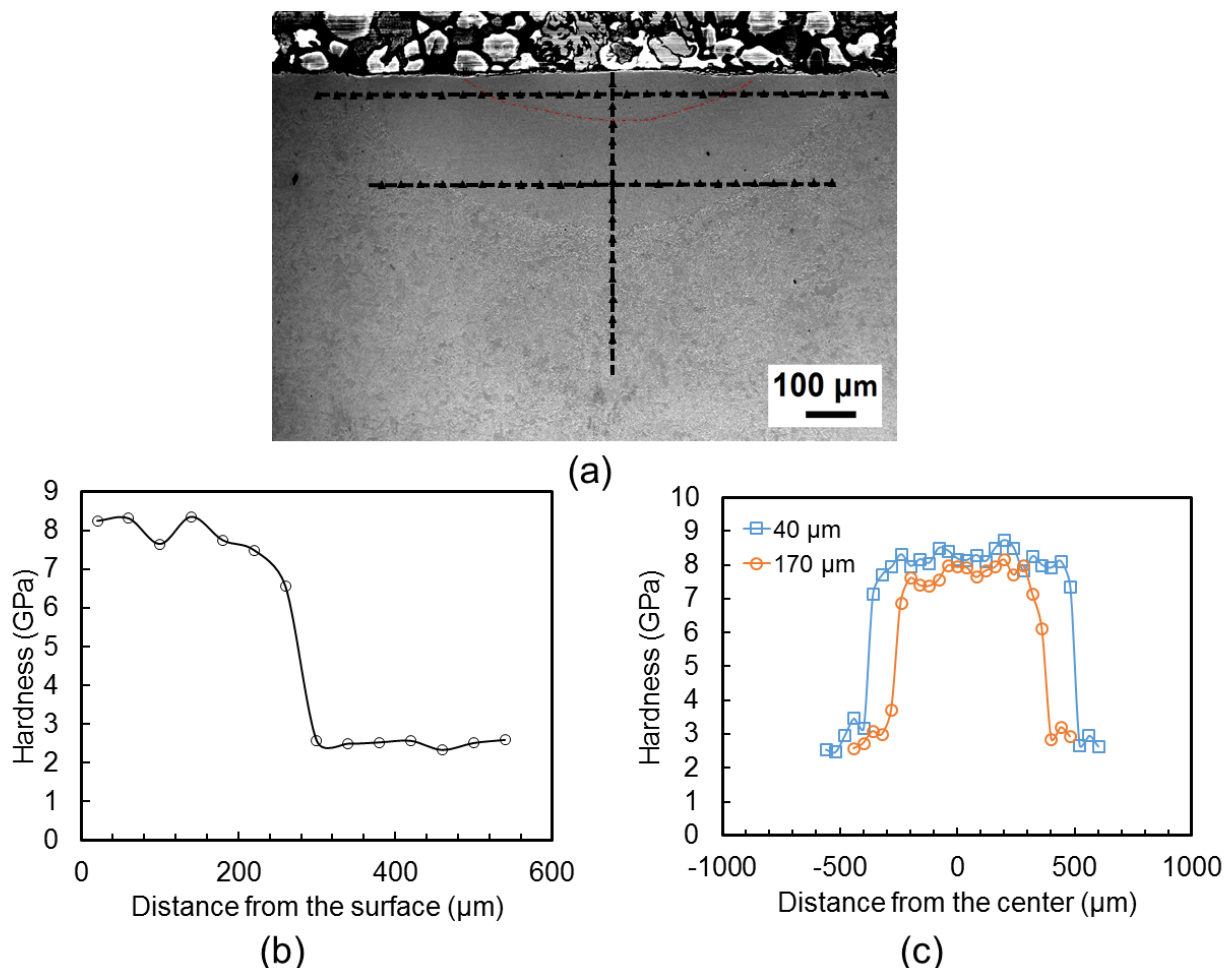
Figure 8. Hardness profile analysis: ( a ) SEM image showing indents made on the specimen, the dotted red line represents the extent of surface melting; ( b ) graph showing the variation of hardness along with depth; and ( c ) the graph showing the variation of hardness across planes parallel to the surface.